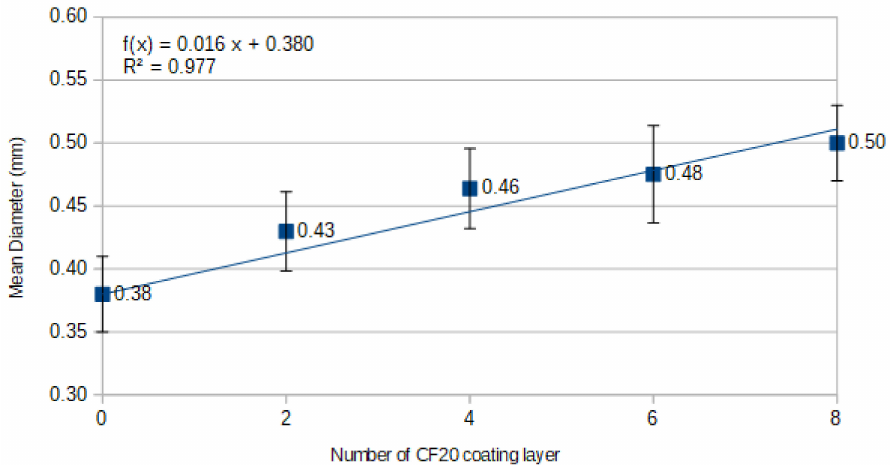
Figure 6. Basic graph representing the apparent diameter of sensor yarn depending on the number of layers of Clevios TM F020 (CF020)